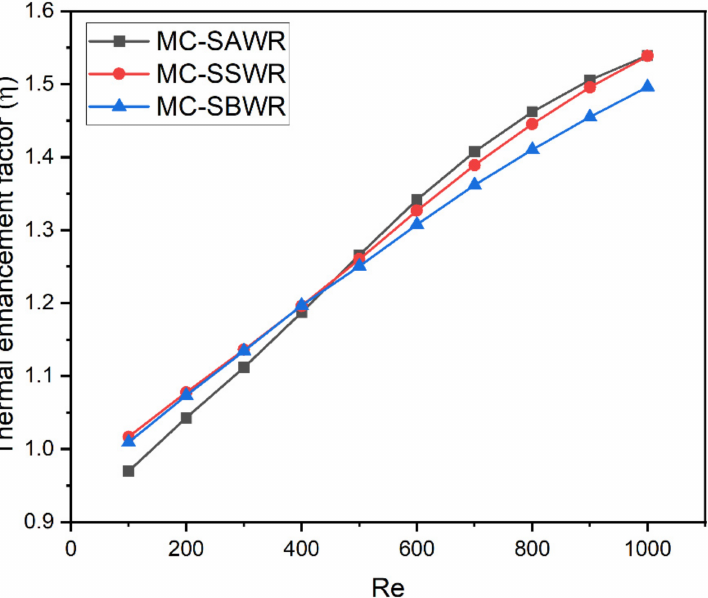
Figure 22. Variation of thermal enhancement factor ( η ) with Re for various MCHS configurations.